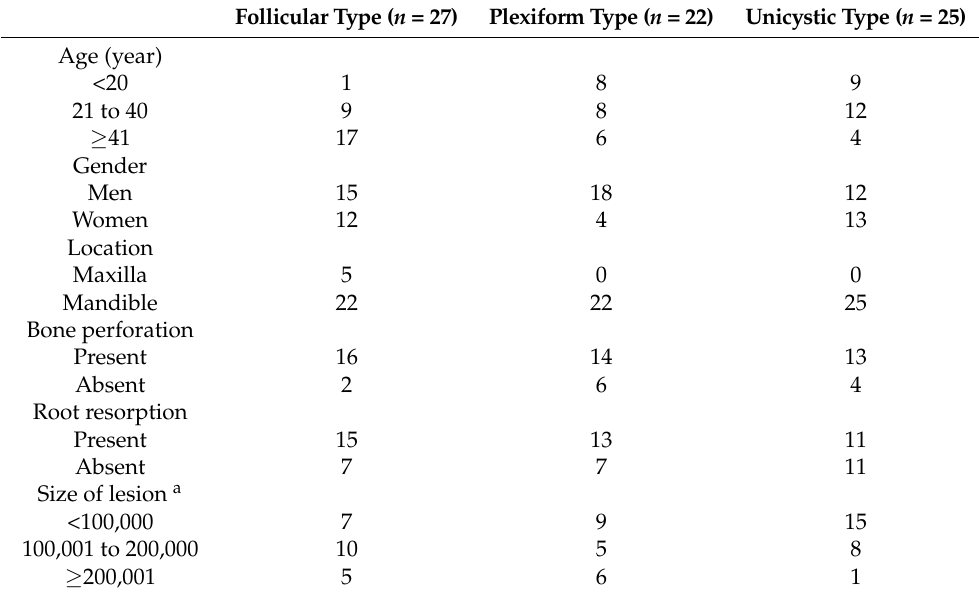
Table 1. Clinical parameters in three histologic patterns of